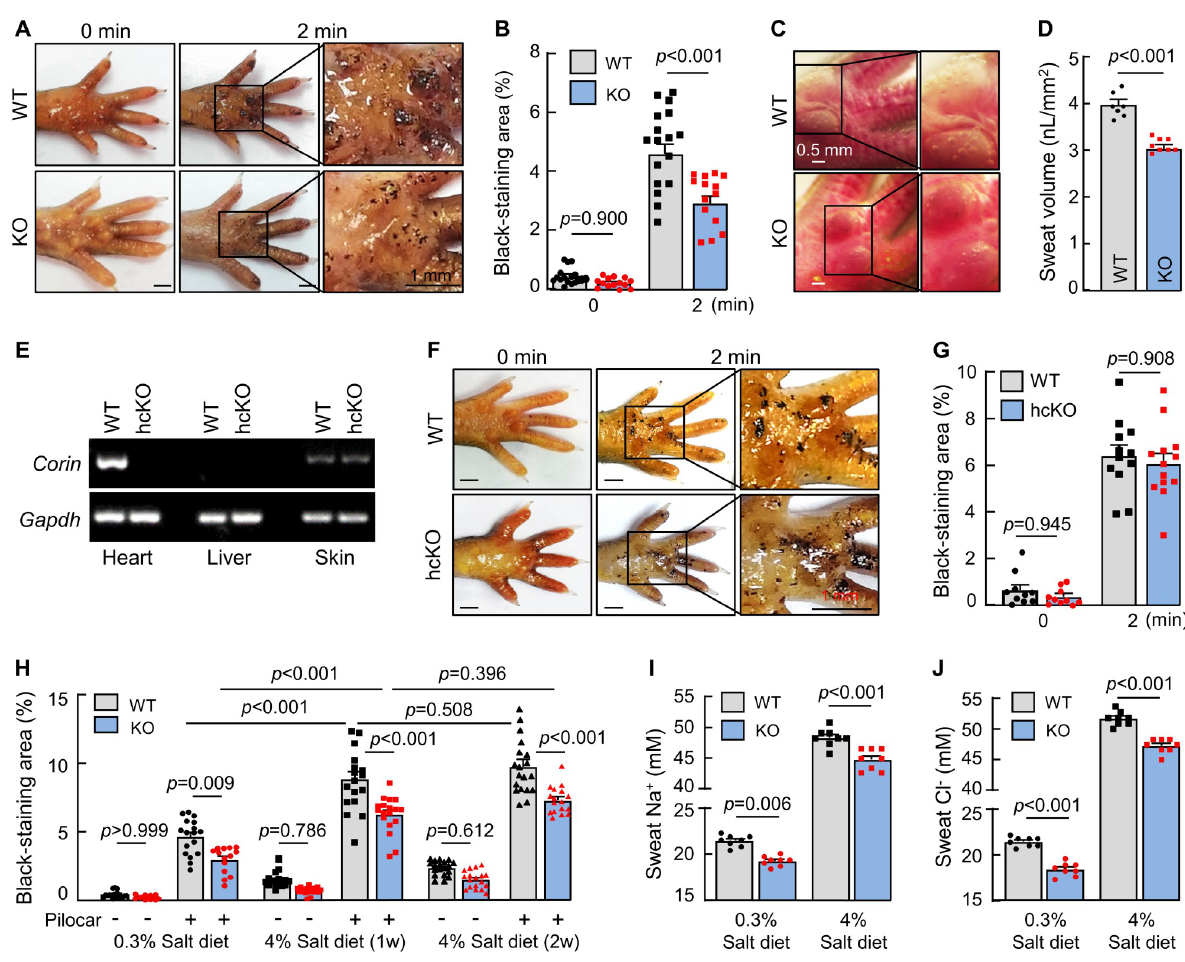
Fig 2. Sweat response in WT, corin KO, and corin hcKO mice. (A and B) An iodine–starch assay was used to measure sweat response in WT and corin KO mice. Photos were taken before (0 min) and 2 min after pilocarpine (pilocar) injection. Sweat excretion is indicated by black staining. Areas of black staining were analyzed by computer software. Quantitative data are presented. (C and D) To calculate sweat volume, photos were taken by a digital camera 10 min after pilocarpine injection. The number and diameter of sweat droplets were analyzed by computer software. Representative photos and quantitative data are presented. (E) RT-PCR analysis of corin expression in hearts, livers, and footpads (skin) from WT and hcKO mice. (F and G) Sweat excretion in WT and corin hcKO mice was analyzed by the iodine–starch assay. Representative photos and quantitative data are shown. (H) Sweat excretion in WT and corin KO mice on 0.3% or 4% salt diet before ( − ) and 2 min after (+) pilocarpine (pilocar) injection. (I and J) Sweat Na + (I) and Cl − (J) levels in WT and corin KO mice on 0.3% or 4% salt diet and with pilocarpine injection. In bar graphs, data are mean ± SEM. Each dot represents data from 1 mouse, except for sweat Na + and Cl − data, in which each dot represents data from 8 paws of 2 mice. P values were analyzed by Student t test or 1-way ANOVA, and the original numerical values are in S1 Data. hcKO, heart- conditional corin KO; KO, knockout; RT-PCR, reverse transcription PCR; WT, wild-type. hcKO mice (6.4 ± 0.5 versus 6.1 ± 0.4% of paw skin area, n = 12 to 13; P = 0.908) (Fig 2F and 2G), indicating that cardiac corin is unnecessary for sweat excretion.